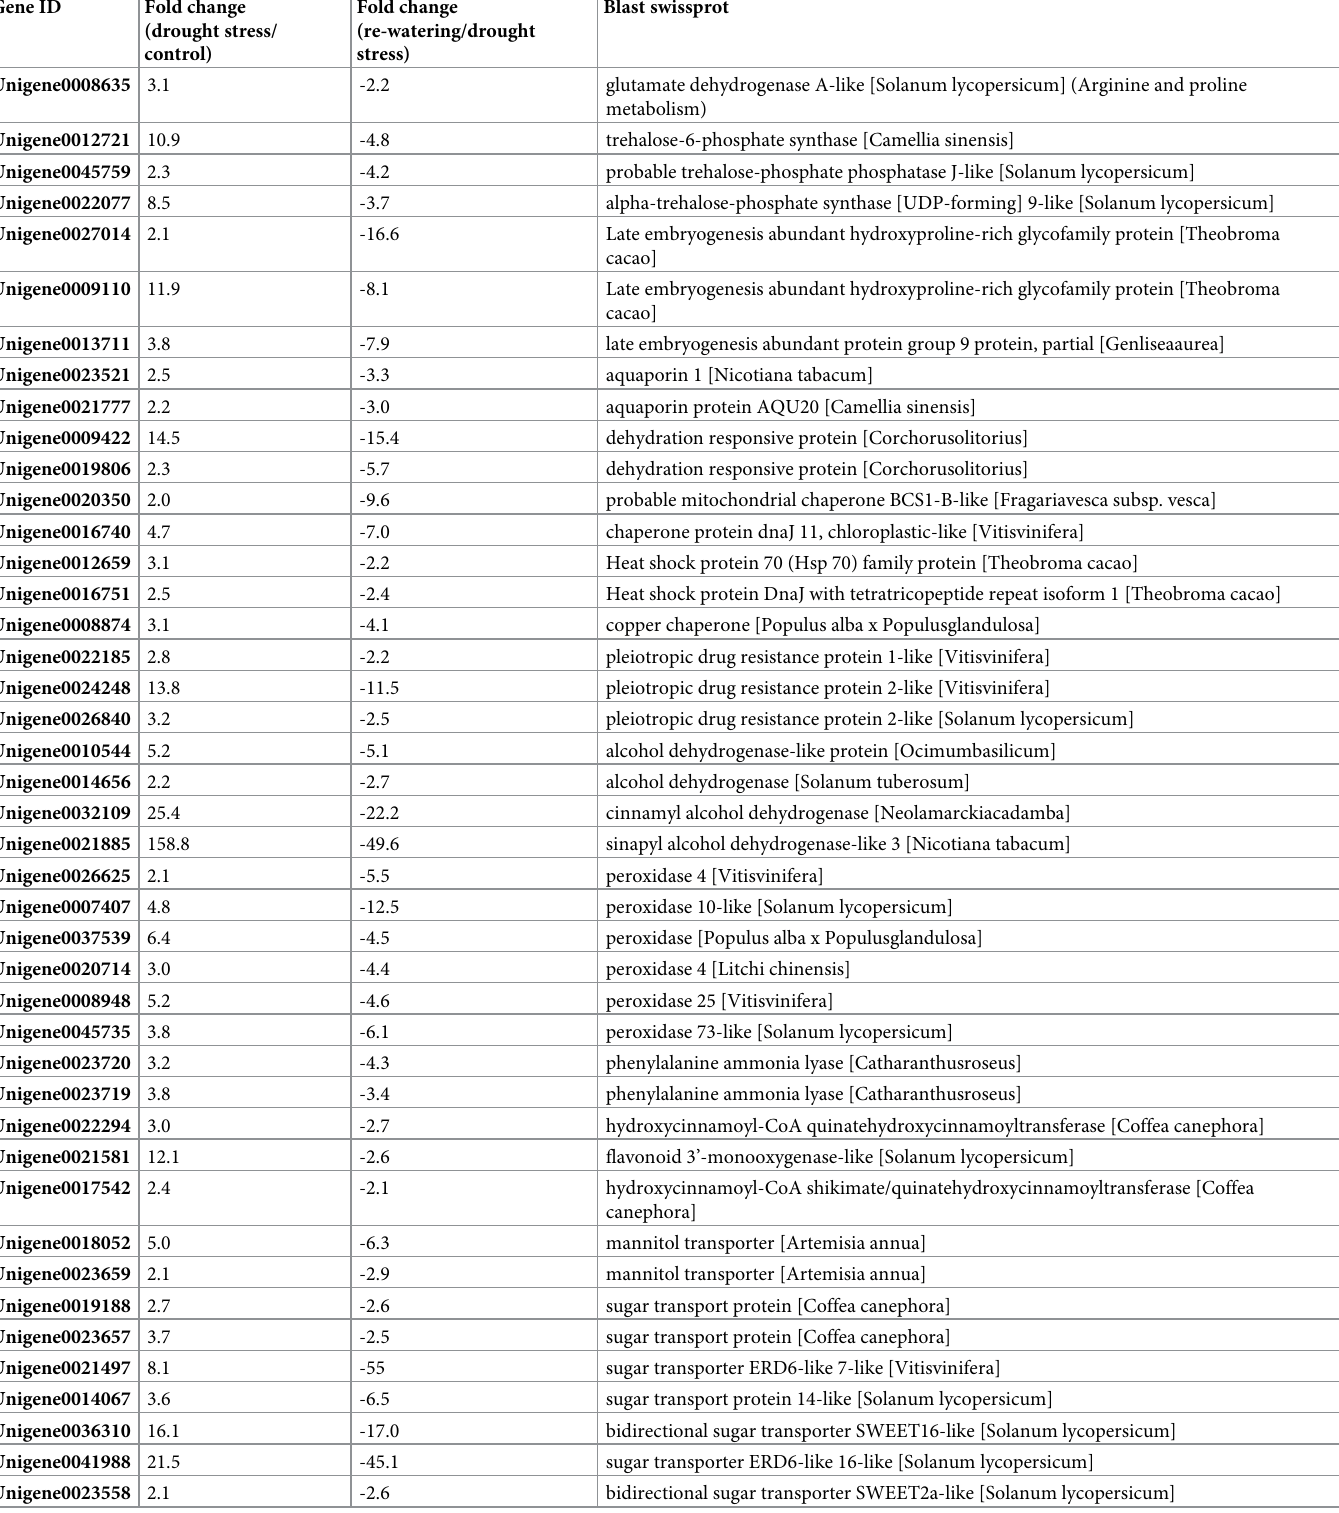
Table 3. The putative functional genes that were induced by drought stress and repressed by re-watering. Gene